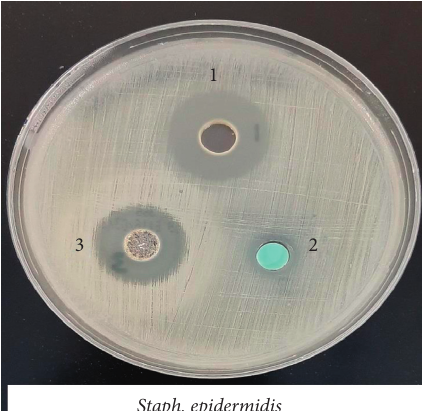
Figure 18: Microbiological screening of Ni(II), Cu(II) and Mn(II) complexes against Candida